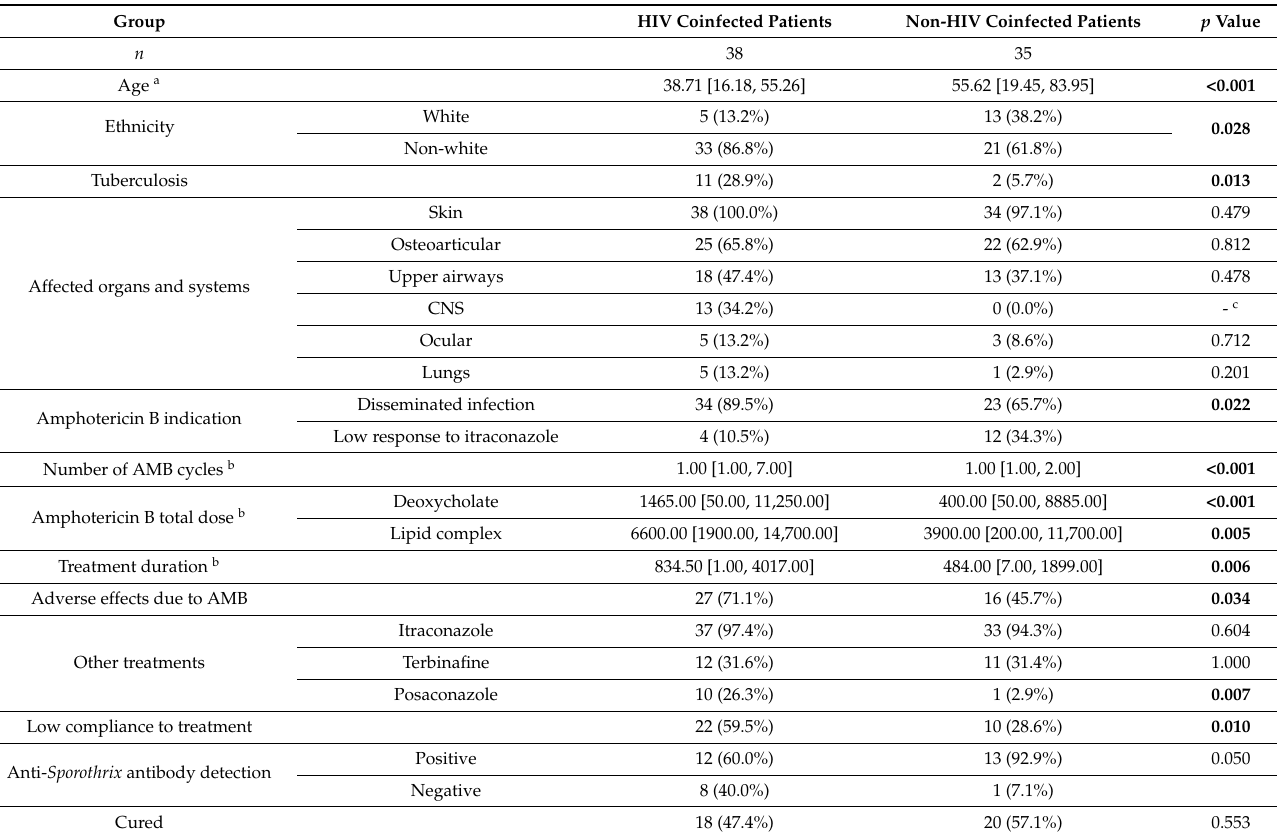
Table 2. Comparative characteristics of 73 patients with sporotrichosis treated with amphotericin B, divided into two groups, HIV coinfected and non-HIV coinfected (FIOCRUZ, Rio de Janeiro, Brazil, 1998–2018).